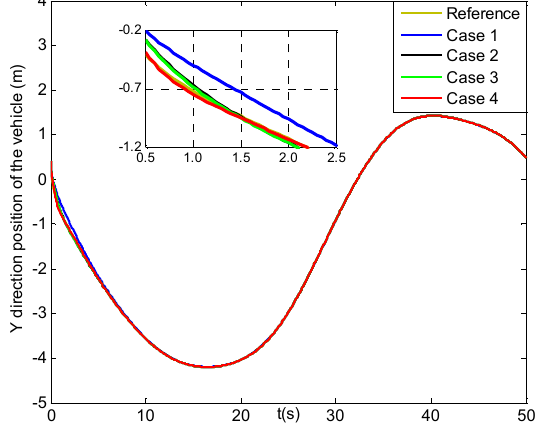
Figure 19. Y direction positions of the vehicle (four cases).